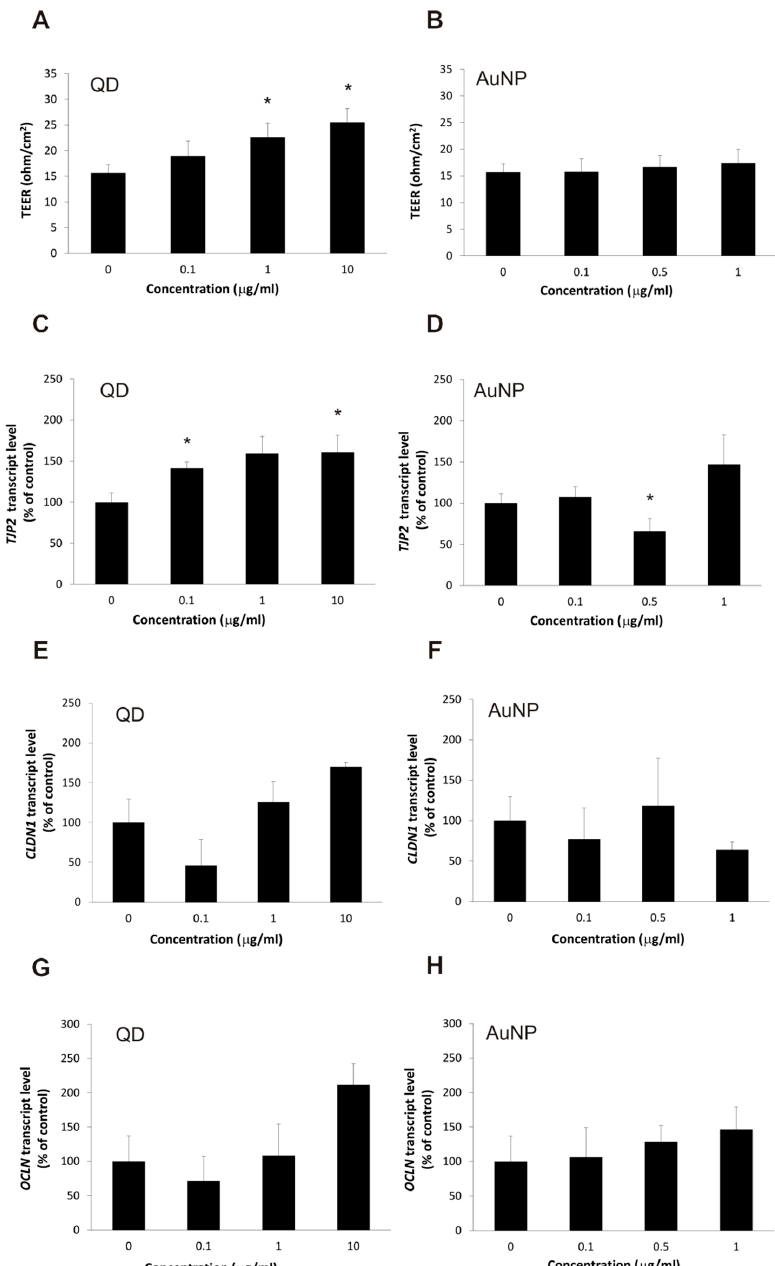
Figure 3. Barrier phenotype properties in brain microvascular endothelial cells exposed to nanopar- ticles. Paracellular transport barrier was assayed by measuring electrical resistance (TEER) in the hCMEC/D3 cell line treated with QD (panel ( A )) and AuNP (panel ( B )) nanoparticles. Calculated TEER values (reported TEER) measured using the Millicell multi-well volt-ohm meter. Data pre- sented as average ± S.D. ( n = 30), asterisks indicate differences from control (untreated cells) which were statistically significant at p < 0.05. Expression of tight junction proteins in the hCMEC/D3 cell line, treated with QD (panels ( C , E , G )) and AuNP (panels ( D , F , H )) nanoparticles, was assayed by real-time RT-PCR for cognate mRNAs (encoding ZO-2—panels ( C , D ); claudin 1—panels ( E , F ); and occludin—panels ( G , H )), calculated as the relative copy number values per housekeeping gene index and presented as average ± S.D. ( n = 3 in panels ( E , F ); n = 4 in panels ( C , D , G , H )); asterisks indicate differences from the control (untreated cells) which were statistically significant at p <